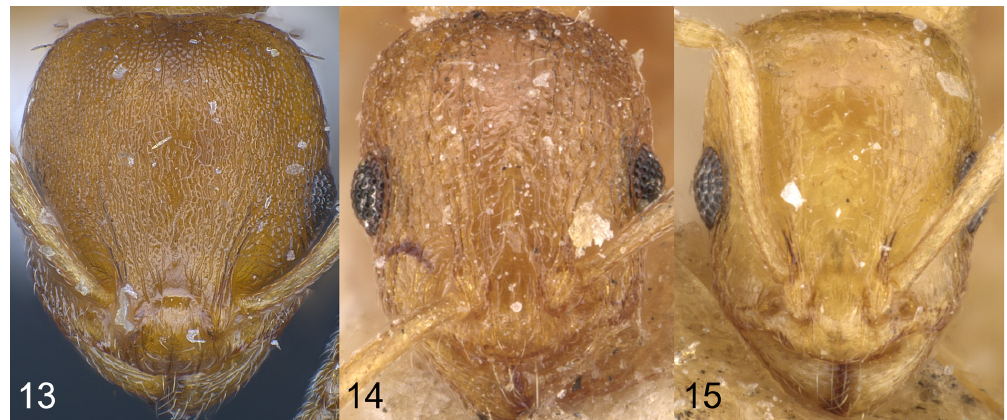
Figs 13–15. Head sculpture variation in workers of Temnothorax Mayr, 1861, photos from www.antweb.org, specimen identifiers in parentheses. 13 . T. alienus Schulz, Heinze & Pusch, 2007, type specimen from Italy (ANTWEB1041297), photo by Roland Schultz, weak longitudinal striae on a background of dense alveolate sculpture. 14 . T. flavicornis (Emery, 1870), type specimen from Italy (CASENT0904761), photo by Will Ericson, strong longitudinal striae with a shiny background. 15 . T. tebessae (Forel, 1890), type specimen from Algeria (CASENT0909034), photo by Will Ericson, extremely weak and few longitudinal striae on a shiny